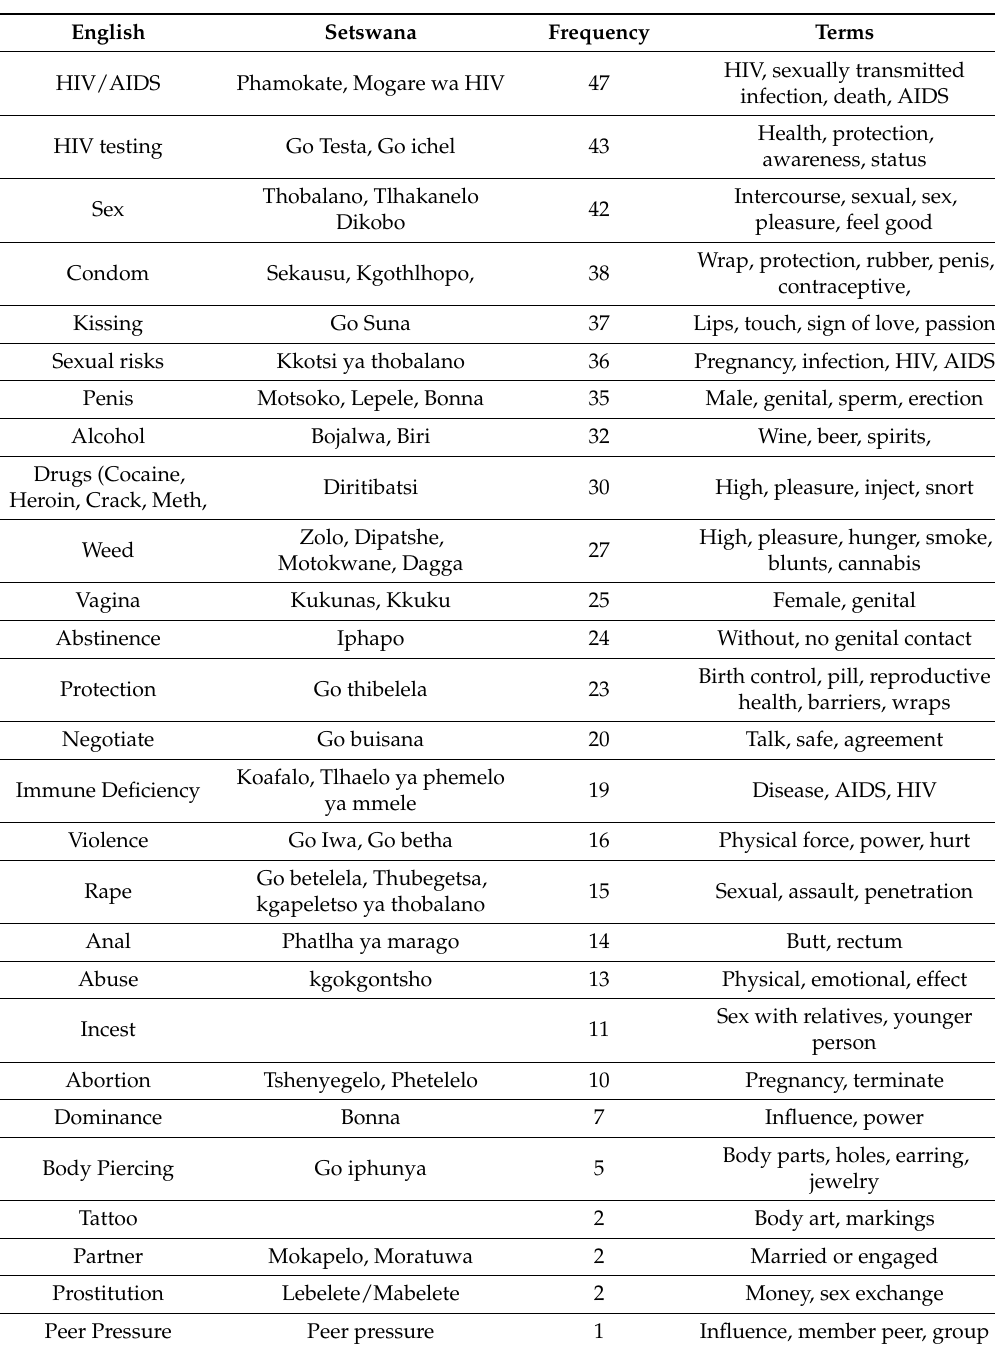
Table 2. Frequency of the 576 Tweets and content analysis of the top 25 users’ commonly used words pertaining to risky